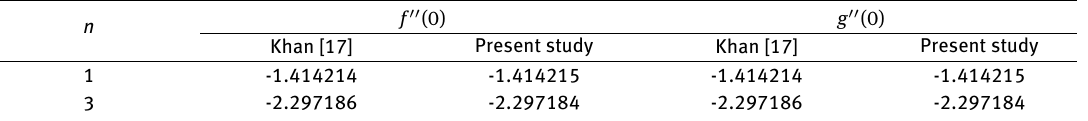
Table 1: Comparison of f (cid:48)(cid:48) (0) and g (cid:48)(cid:48) (0) for different values of n, when β → ∞ , c = 1, M = K = Ec x = Ec y = R = 0.